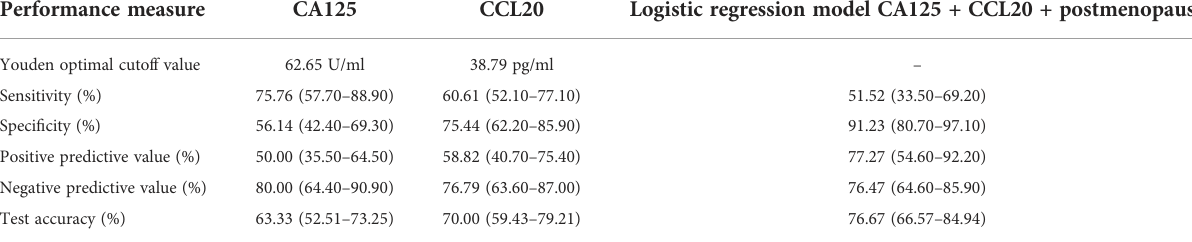
TABLE 3 Diagnostic performances and optimal cutoff values of serum CA125 and CCL20 levels for discriminating between benign disease and ovarian cancer. Performance